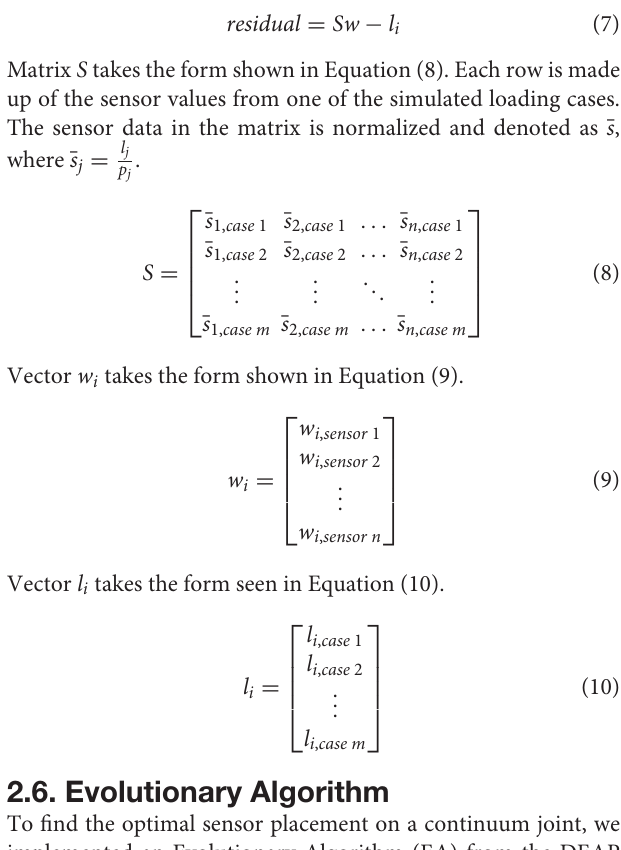
covers. This method assumes that all of the segments covered by a sensor have the same angle of